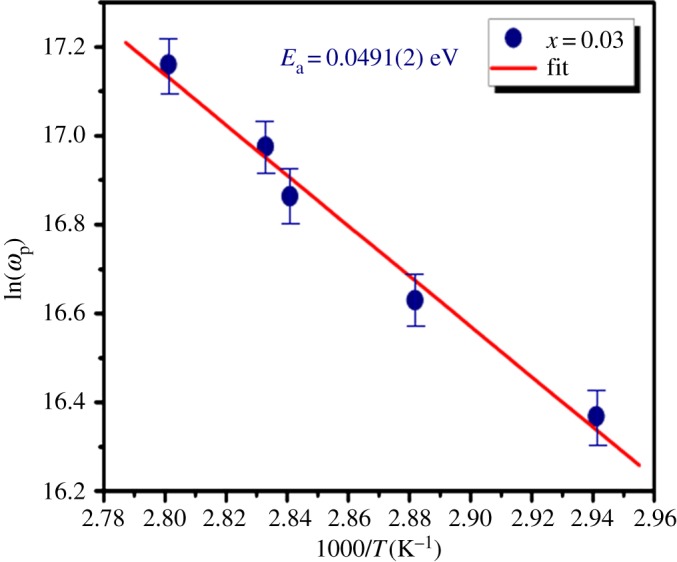
The variation of log(ωmax) as a function of 1000/T for LDSMO compound.